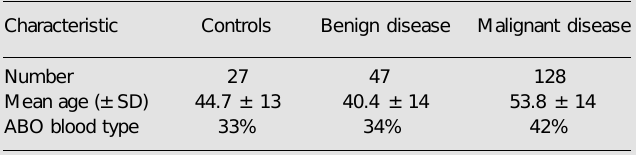
Table 1. Characteristics of the women with breast disease and normal controls.